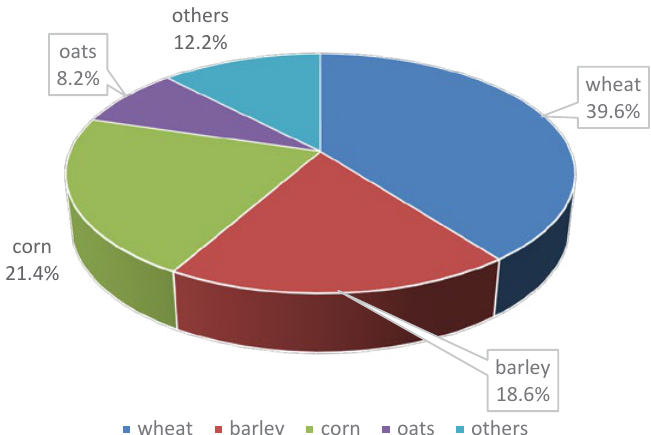
Fig. 1: The structure of grain crops areas in Rivne region (is based on the averaged values of the sown area for the period of 2012 - 2016 years) (State Statistic Service of Ukraine, 2010)